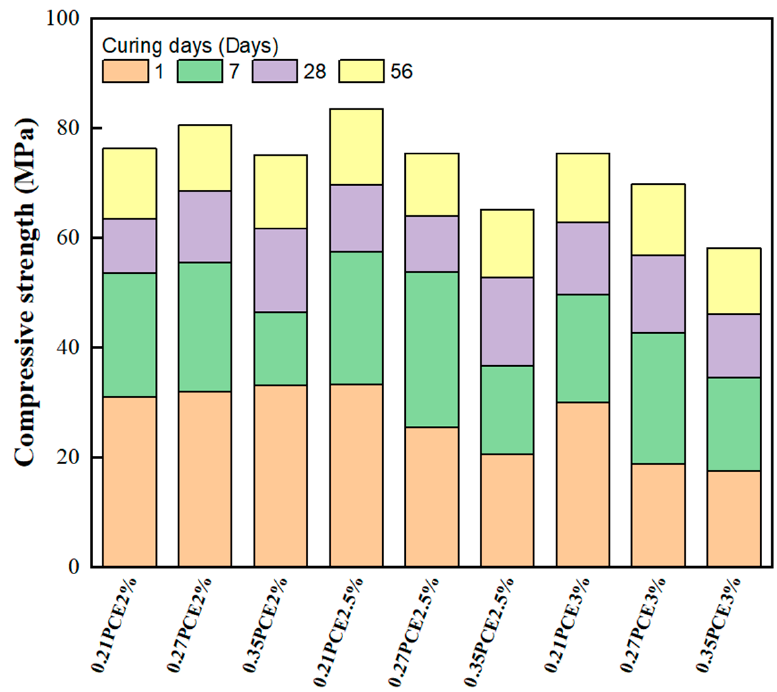
Figure 7. Compressive strength of green and ecofriendly grouting material with PCE.